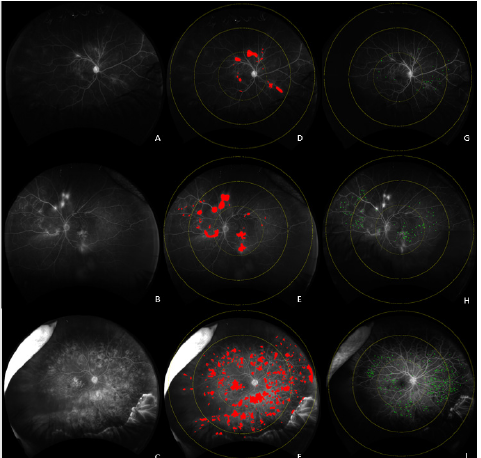
Figure 1 . Late UWFA images of eyes not requiring treatment ( A ), requiring delayed treatment ( B ) requiring immediate treatment ( C ), and their corresponding leakage ( D – F ), segmentation, and microaneurysm ( G – I ) segmentations.